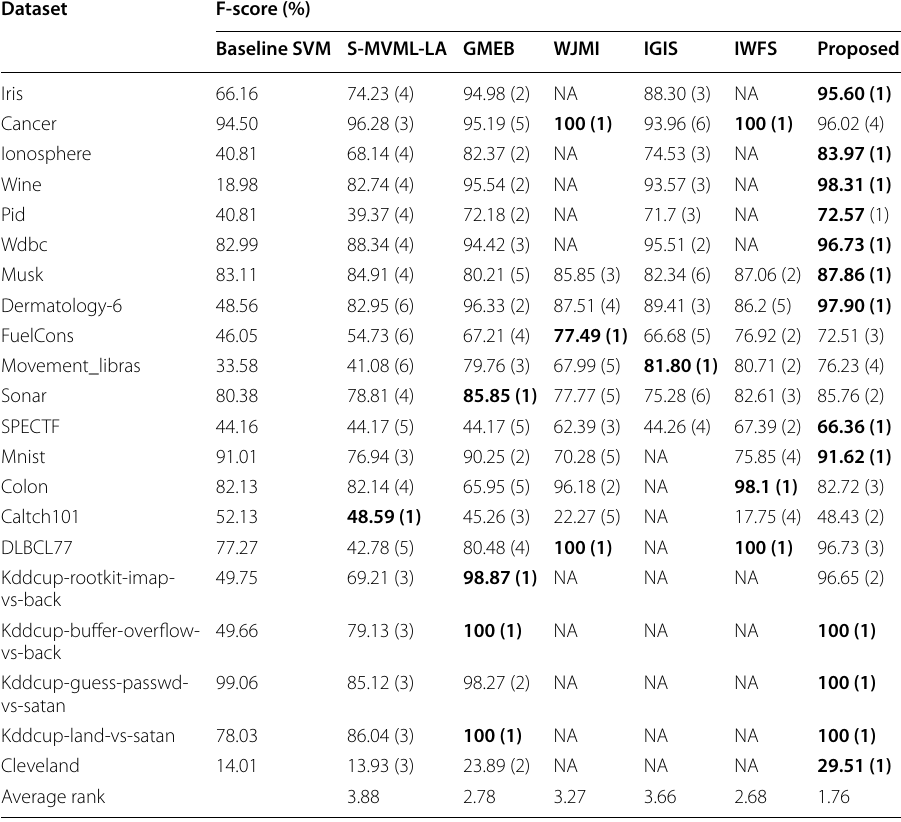
The numbers in bold are the best accuracies achieved on the dataset